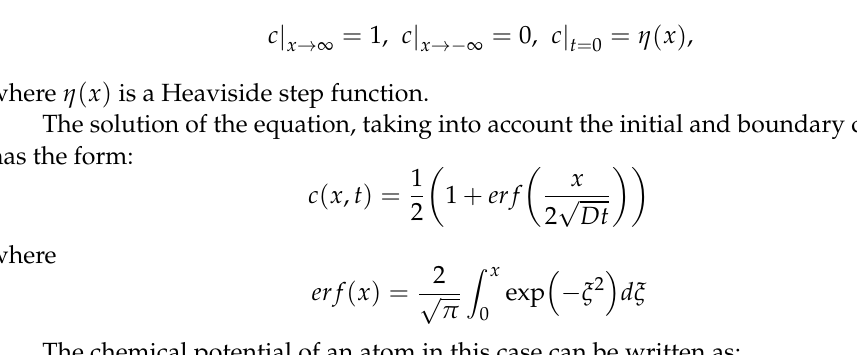
Figure 1. Mutual diffusion of atoms of two substances.